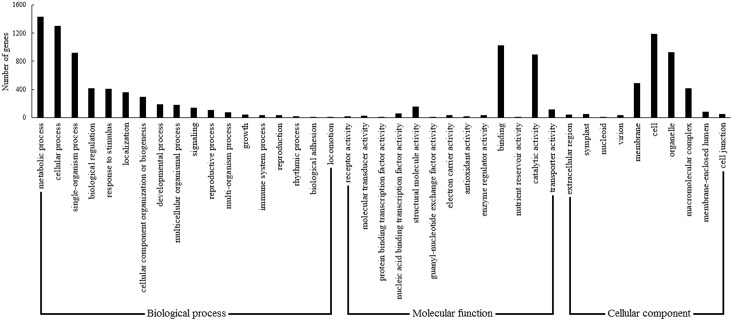
GO classification of the probes used in the latex cDNA microarray.The 1689 unigenes (probes) with significant similarity in nr protein databases were assigned to GO classifications.